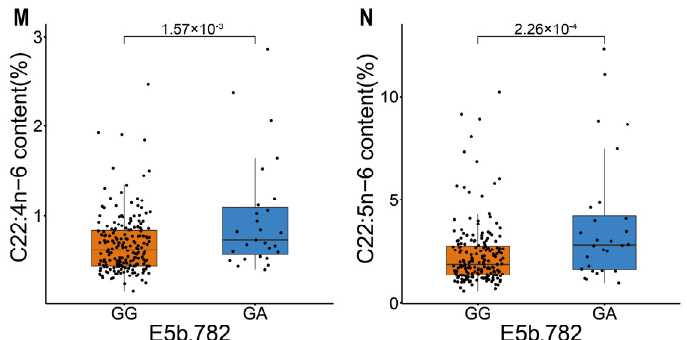
Figure 1. Box plots showing significant PUFA content differences between two genotypes at three loci, E5a.87, E5b.172, and E5b.782. The corrected p values were calculated with ANOVA. ( A ): PUFA content values of genotype GG and AG atE5a.87 locus; ( B – J ): PUFA content values of genotype CC and CT at E5b.172 locus; ( K – N ): PUFA content values of genotype GG and GA at E5b.782 locus. Two ns-cSNPs in elovl5b , E5b.172 and E5b.782, were significantly associated with sev- eral PUFA contents by using both GLM and ANOVA (Table 2). The ns-cSNP of E5b.172 PUFAs contents, including four n-3 PUFAs (C18:3n-3, C20:3n-3, C20:4n-3, and C22:5n-3) and five n-6 PUFAs (C18:2n-6, C20:3n-6, C20:4n-6, C22:4n-6, and C22:5n-6) (Figure 1B–J).